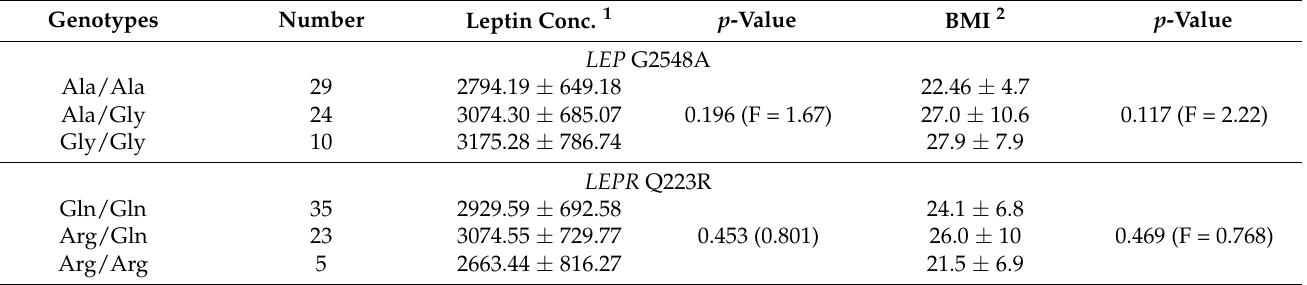
Table 4. Comparison of the mean leptin and BMI values in different genotypes of G2548A Lep and Q223A LepR polymorphisms in the studied population.